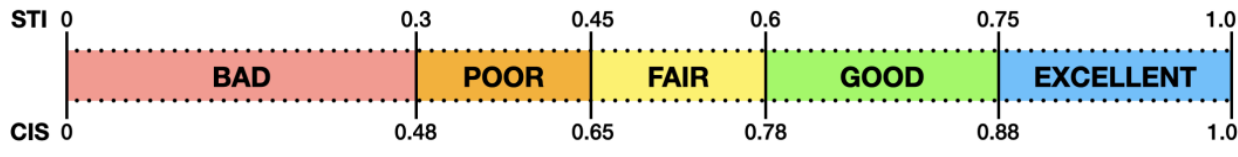
Figure 1. Speech Transmission Index (STI) rating and the Common Intelligibility Scale (CIS). Doelle [34] recommended that the RT for traditional churches depends according to the respective church sizes. Since all churches selected in this study are Roman Catholic churches, the recommended RT is determined as follows: C1, P1, P2 is between 2.0 and 2.6 s, and R1 is 1.9